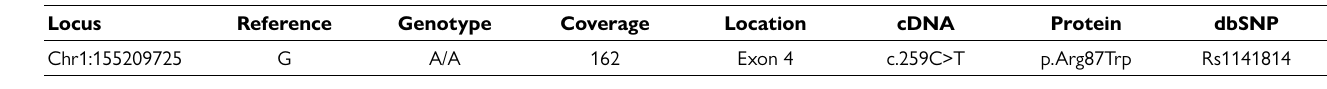
Table 2. Variants found along the